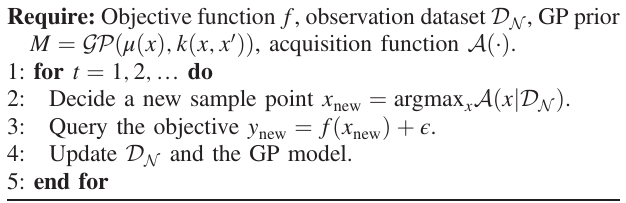
Algorithm 1. Bayesian